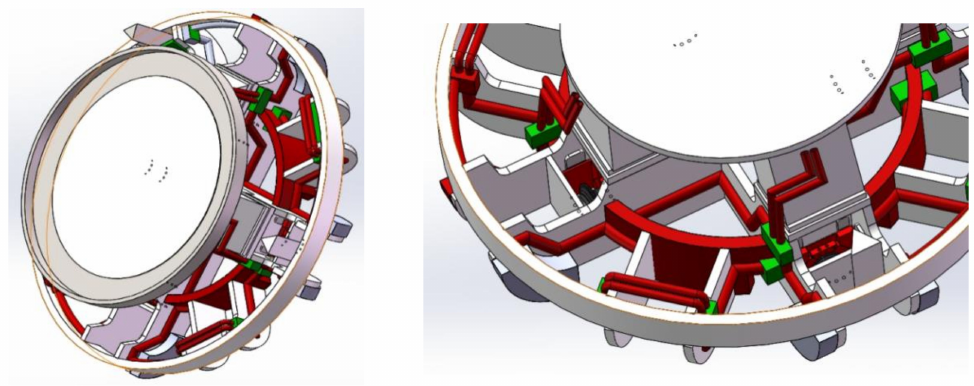
Figure 2. Distribution of the frozen pipeline in the cutter head.